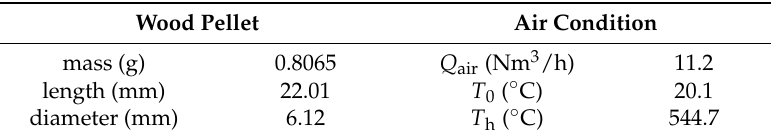
Table 2. Wood pellet size and air